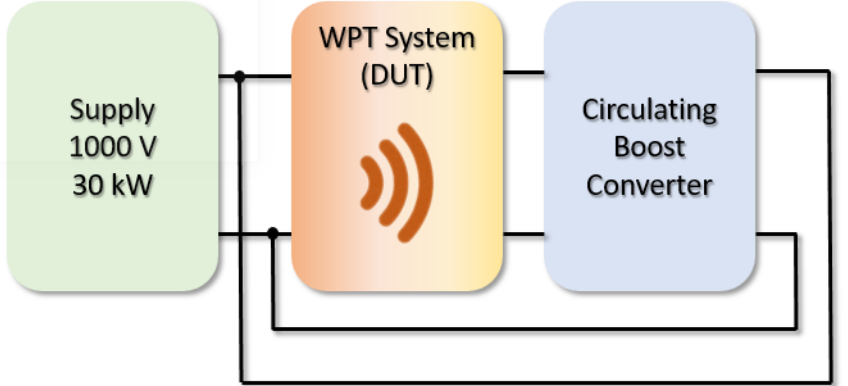
Figure 2. Schematization of the test-bench for the experimental validation for the WPT system under analysis.